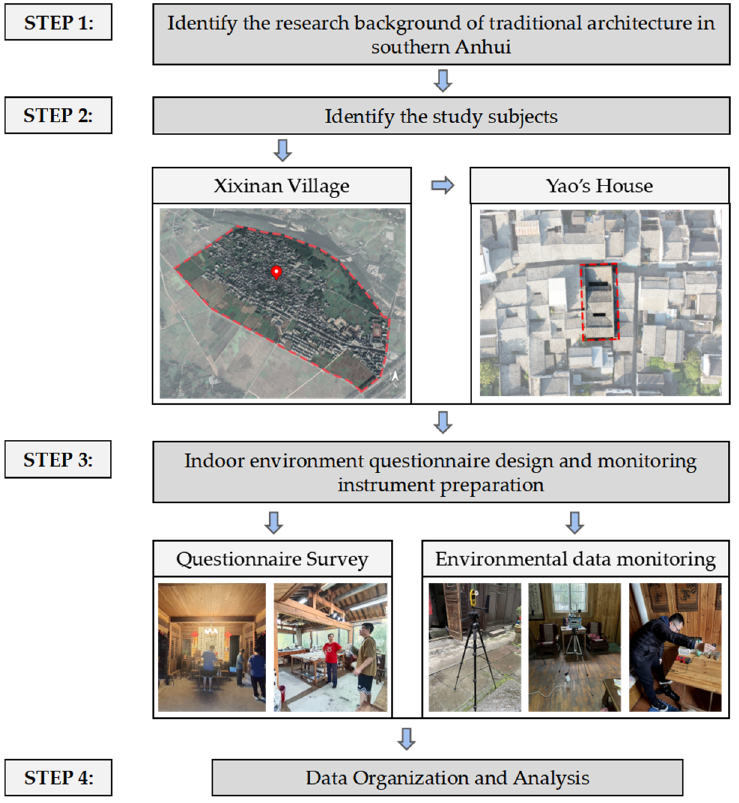
Figure 1. Research